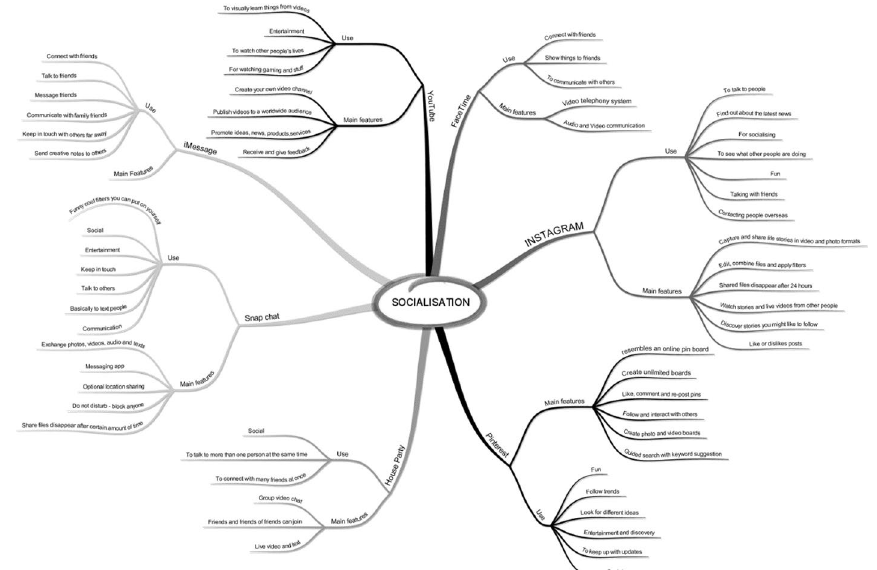
Fig. 5 Students’ use of technology for social